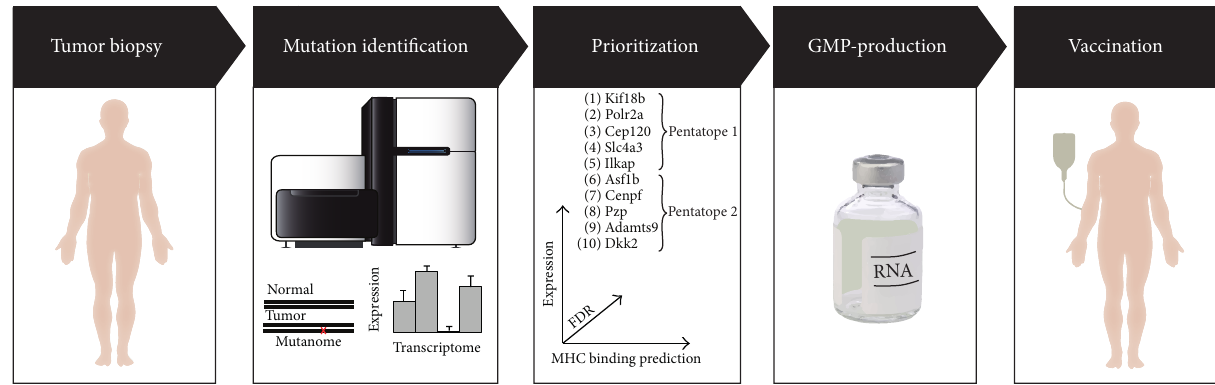
Figure 1: Concept of mutanome engineered RNA immunotherapy (MERIT). Next generation sequencing of nucleic acid from a tumor biopsy and healthy tissue is used to identify expressed, nonsynonymous, somatic mutations. Vaccine targets are selected based on several parameters suchasexpression,theirMHCbindingprediction,andrestrictionaswellasafalsediscoveryrate(FDR)[16].Mutationsencodedonpentatope RNAs are produced under GMP conditions and used for therapeutic